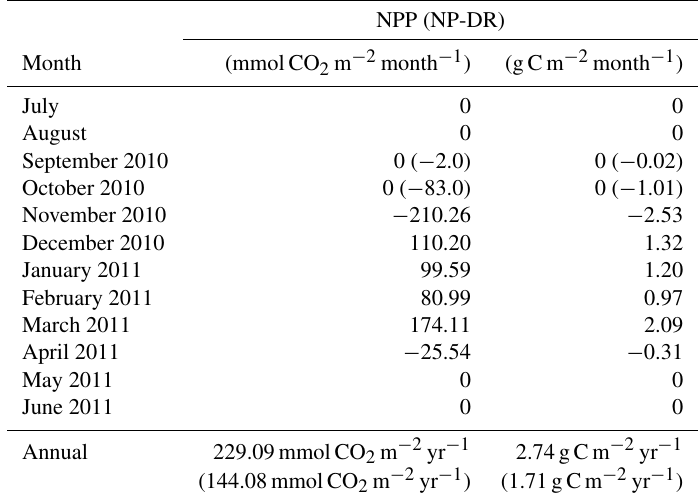
Table 2. Monthly net primary productivity of the Boodjamulla biological soil crust (values in brackets are an estimation only, not based on measurements; see text for explanation).